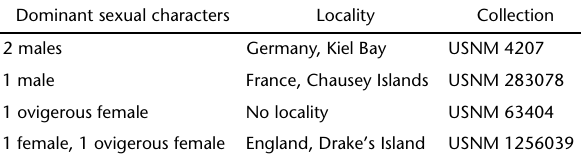
Table 1. Pisidia longicornis , intersex individuals, with secondary sexual characters, locality and catalog number data. Dominant sexual